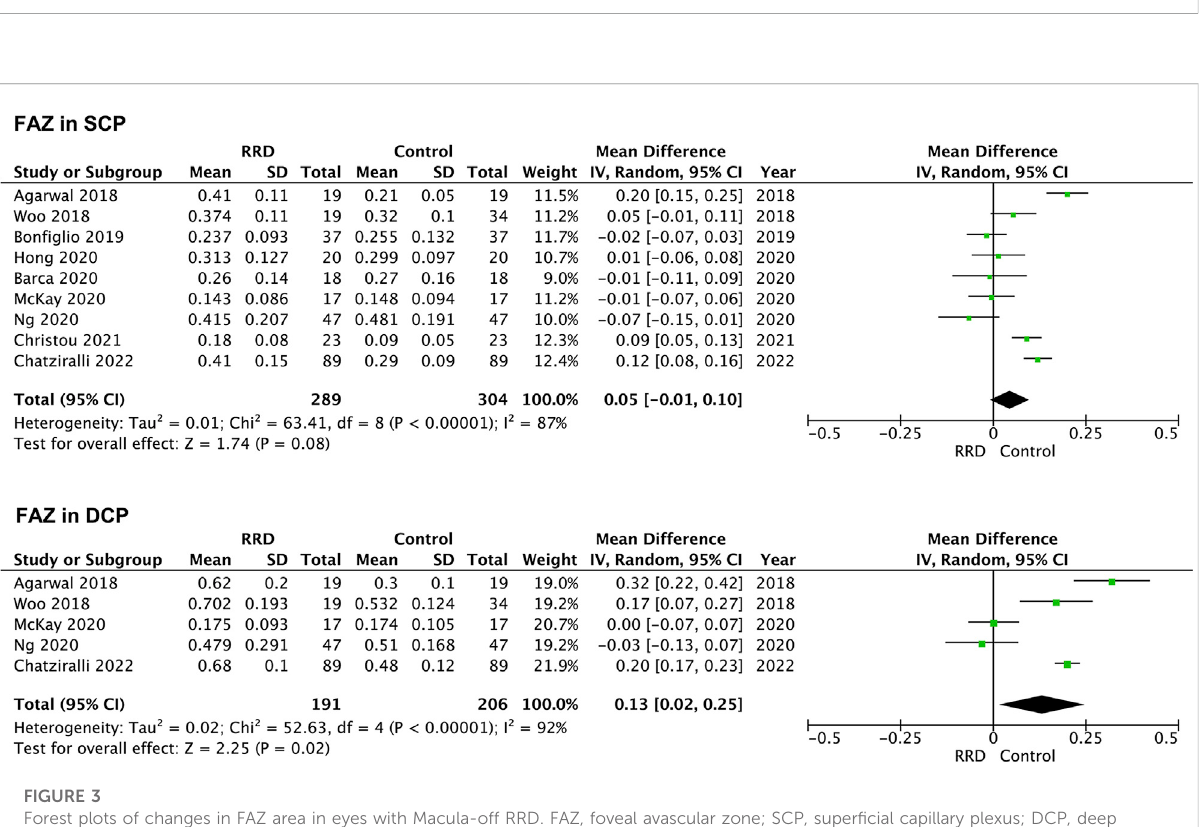
FIGURE 2 Forest plots of changes in FAZ area in eyes with Macula-on RRD. FAZ, foveal avascular zone; SCP, super fi cial capillary plexus; DCP, deep capillary plexus, RRD, rhegmatogenous retinal detachment.